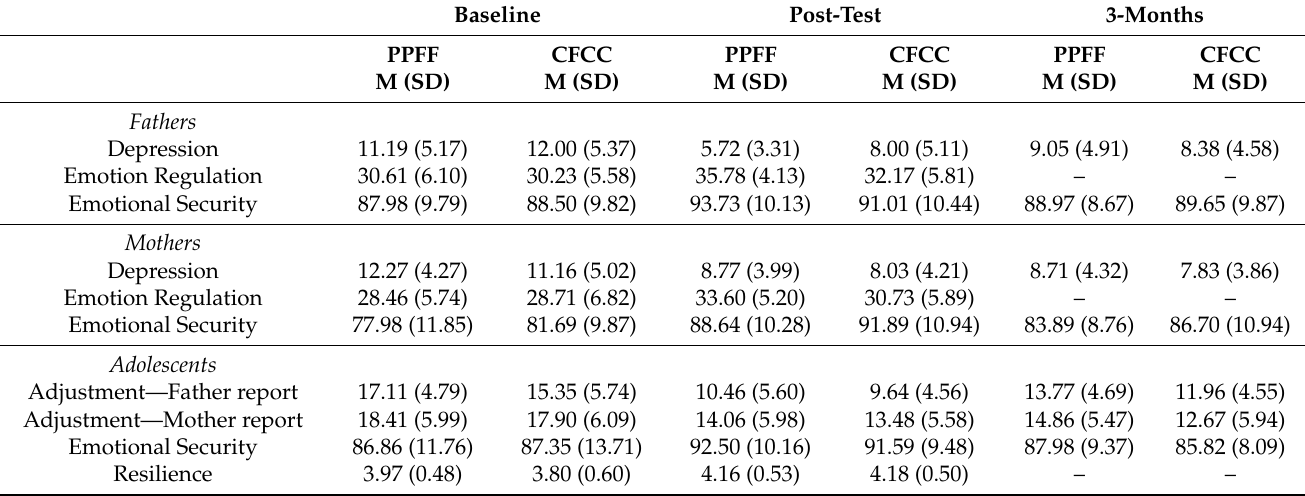
Table 1. Descriptive statistics for study measures, by group and across